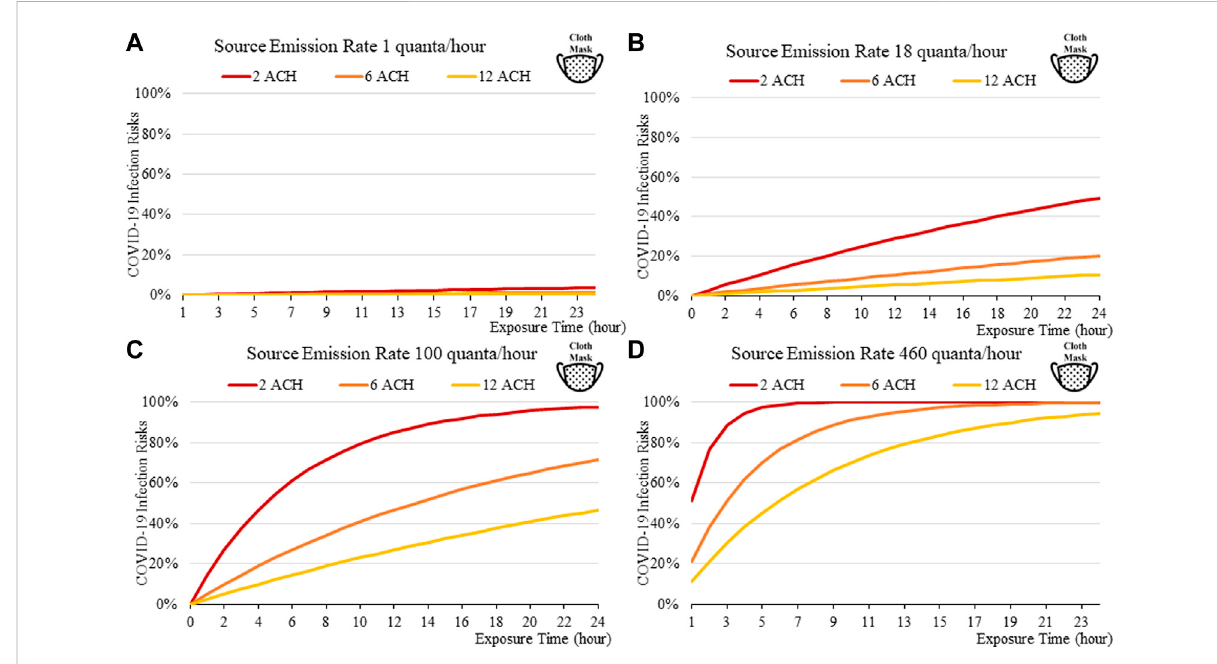
Disease infection risks for the original variant, assuming the receiver and the index patient are both wearing cloth masks with the exhale quanta emission rate of 1 (A) , 18 (B) , 100 (C) , and 460 (D) quanta/hour for the